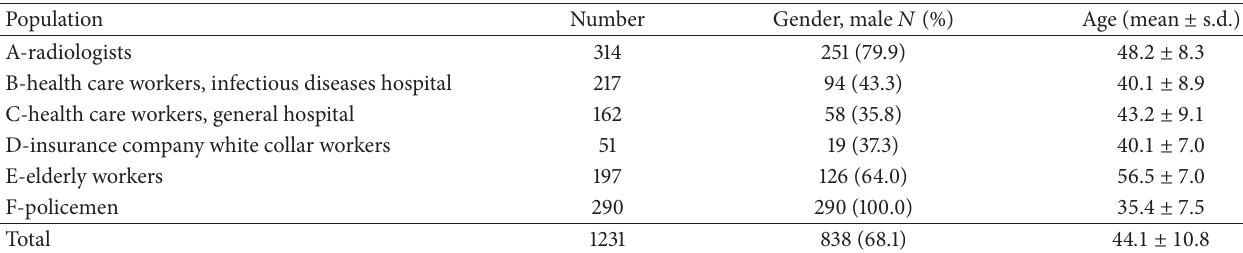
Table 1: Characteristics of the observed